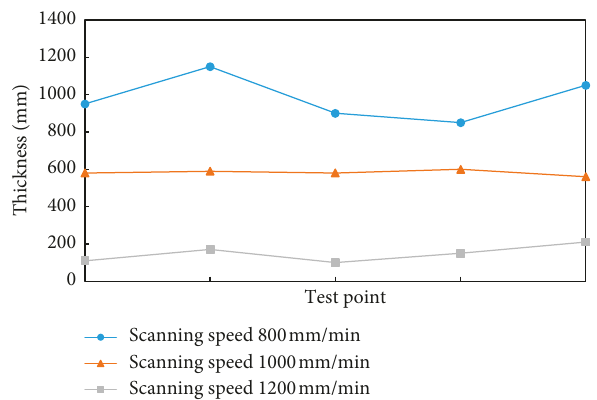
Figure 4: Thickness of the coating with different scanning speeds.